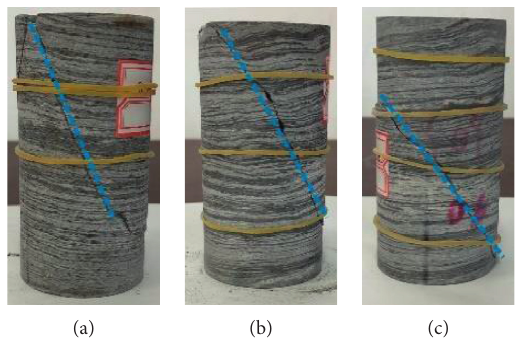
Figure 13: Failure modes of saturated phyllite ( σ α � 62 ° ; and (c) σ 3 � 20MPa, α � 53 ° .